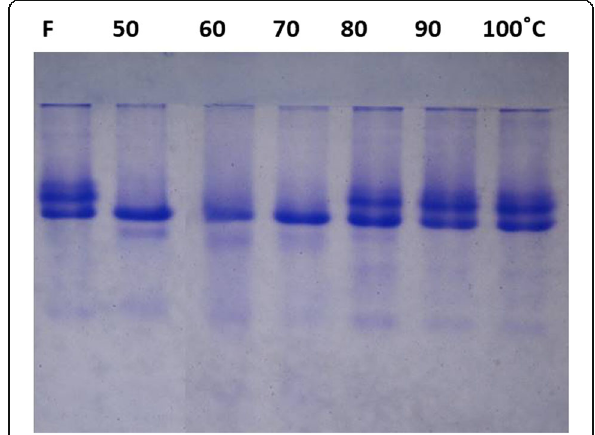
Fig. 6 Effect of temperature on fibrinogenolytic activity of AiP1: lane F is fibrinogen which served as negative control; other lanes represent the temperature (in °C) at which AiP1 was exposed for 1h before incubating